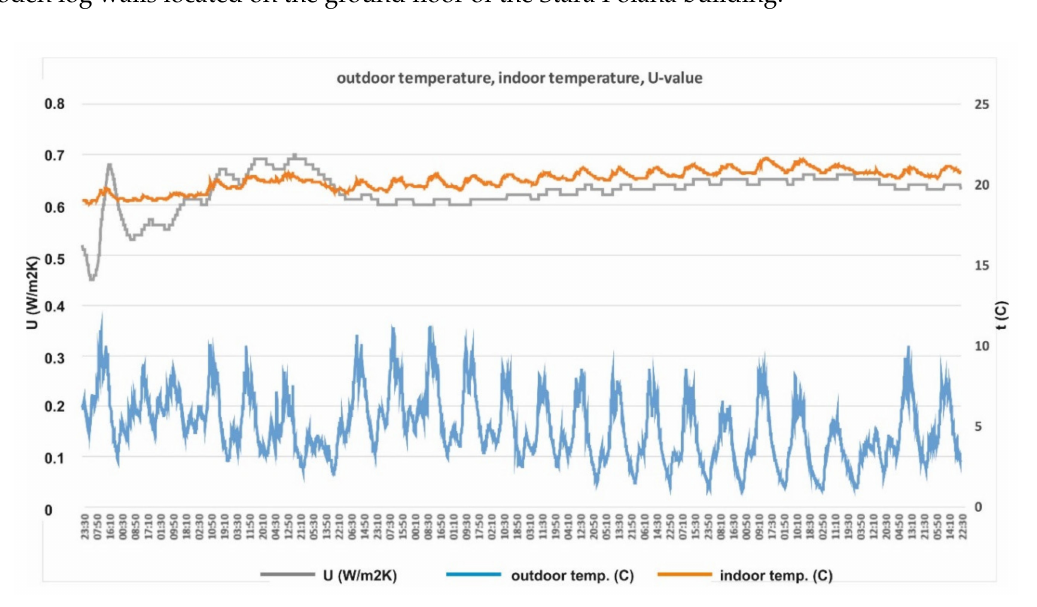
Figure 14. Results of testing intended to determine the actual U thermal transmittance for a wall made from wooden logs, located on the ground floor of the Stara Polana building. Temperature and heat stream density